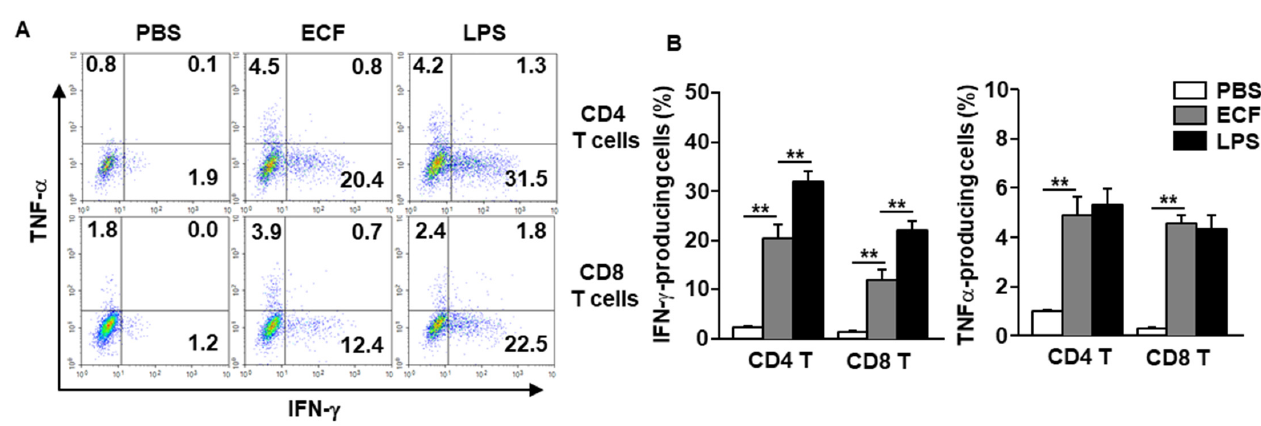
Figure 3. Induction of T helper 1 and cytotoxic T 1 (Tc1) immune responses in the mLN by intranasal administration with ECF. C57BL/6 mice were i . n . administered with 50 mg/kg ECF twice at a 3-day interval. ( A ) Intracellular producing levels of IFN- γ and TNF- α in mLN CD4 and CD8 T cells were measured. ( B ) Mean percentage of IFN- γ -producing ( left panel ) and TNF- α -producing ( right panel ) CD4 and CD8 T cells ( n = 6, two-way analysis of variance, ** p < 0.01).